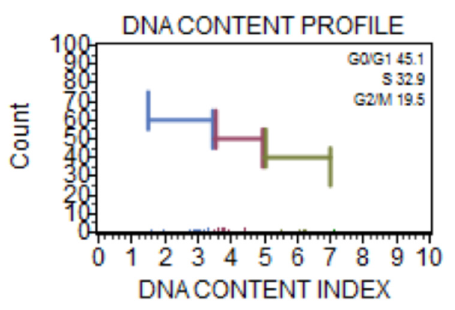
Figure 7. Cell cycle analysis of C6 cells treated with compound 5f .